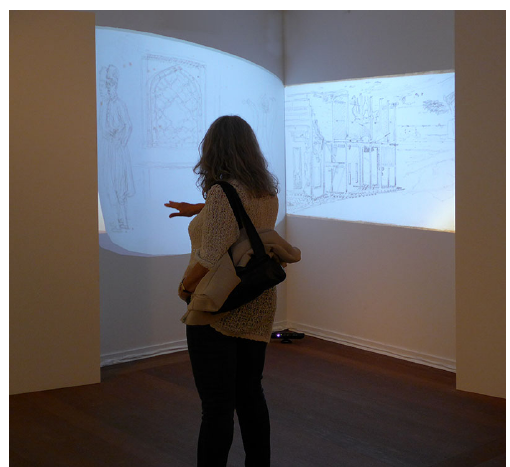
Figure 6. The 3D effect used in Viskbook when a page is turned. (Photo: